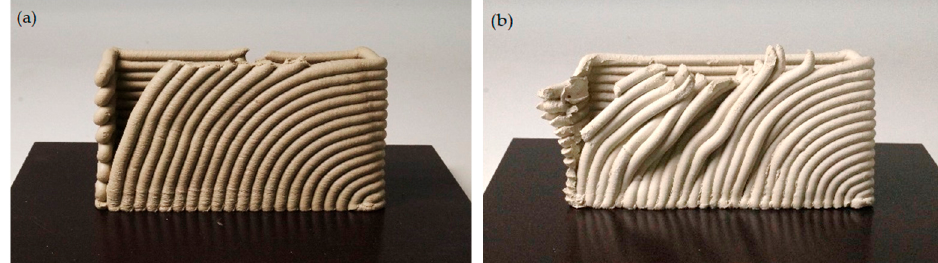
Figure 10. Comparison of different intermediate states of arc geometry I (front side). ( a ) ‘wiping of material’ in the direction of the arc geometry. ( b ) the exact opposite.